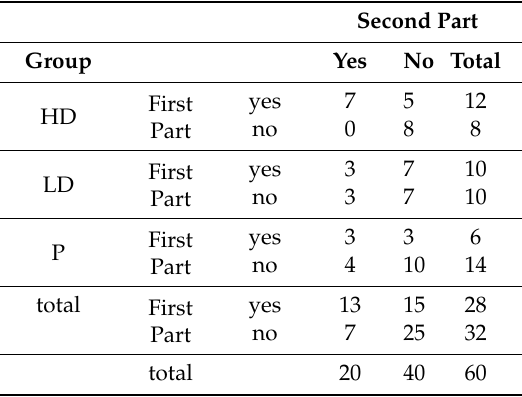
Table 3. Crosstab “sweaty paws” in the waiting room.